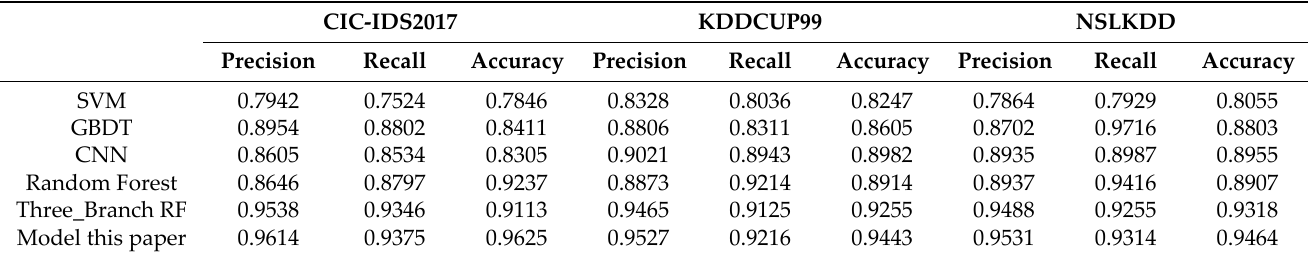
Table 8. Summary of experimental results for the model on the experimental dataset.